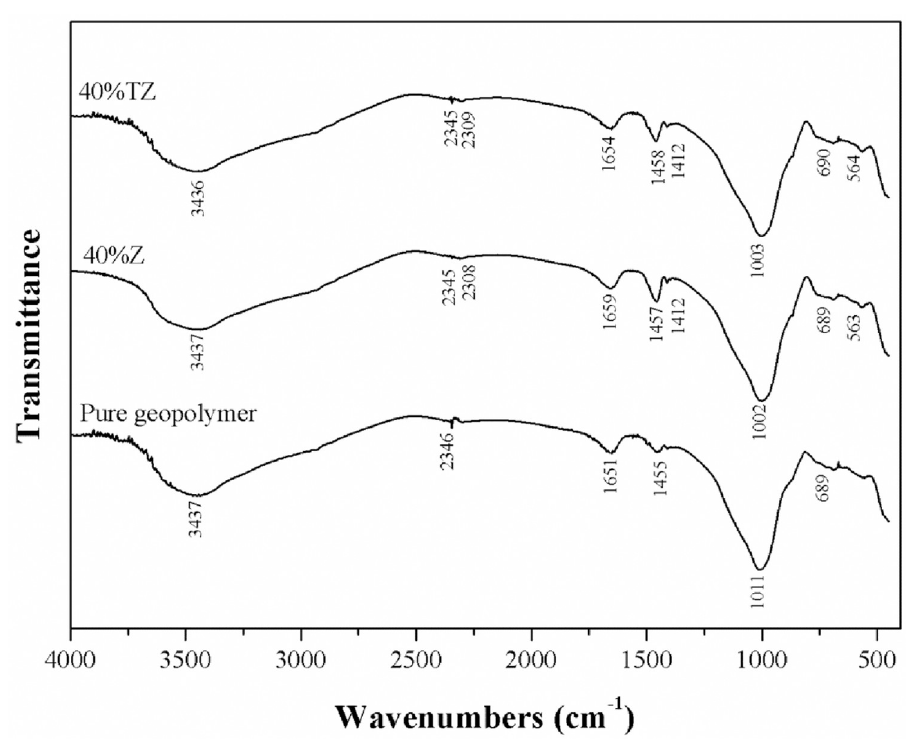
Fig 8. FTIR spectra of MK-based geopolymer with 40 wt% of zeolite and TiO 2 /zeolite.